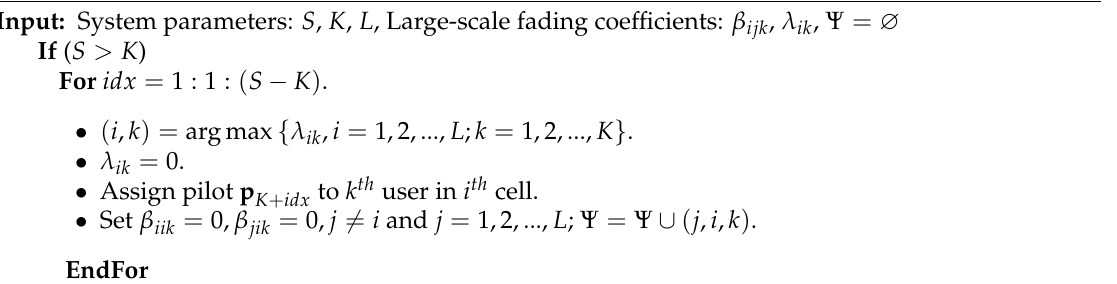
Algorithm 1 Proposed WCPA